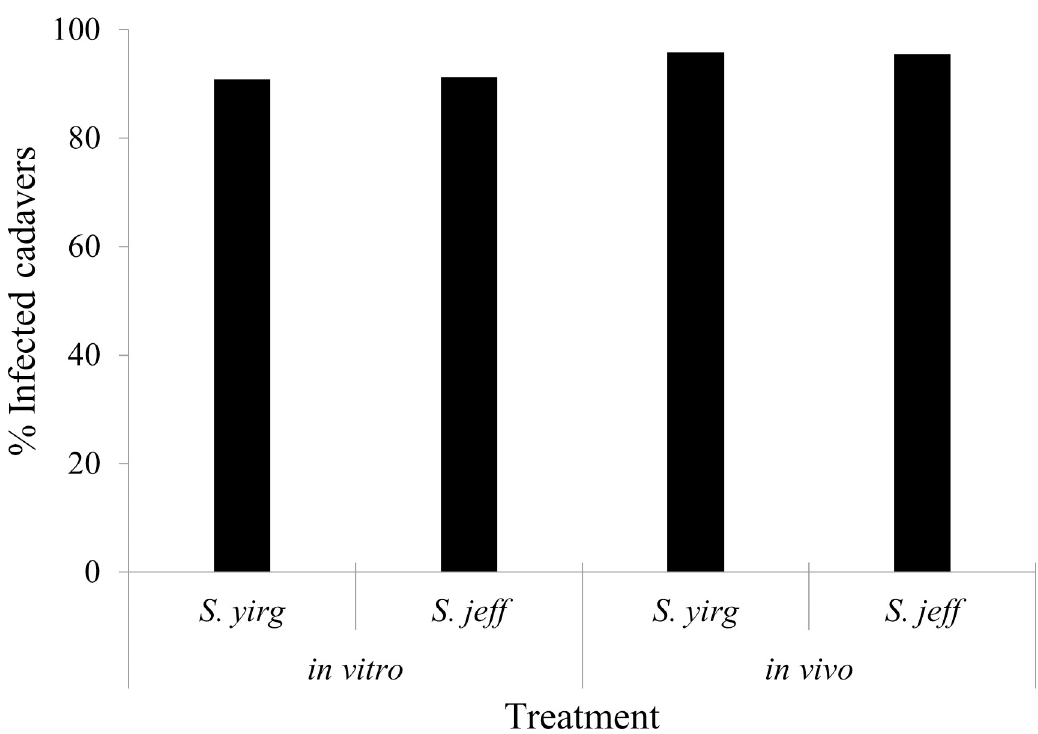
Fig 4. Percentage of Lobesia vanillana cadavers with nematodes present. Cadavers were rinsed and dissected following susceptibility bioassays of in vitro- and in vivo -cultured Steinernema yirgalemense ( S . yirg ) and S . jeffreyense ( S . jeff ), and the presence of infective juveniles within each cadaver was recorded. No significant differences were found between